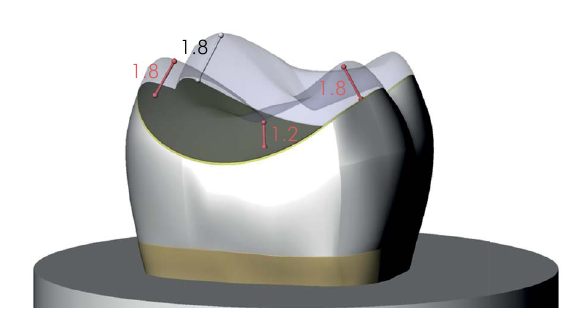
Figure 1. Three-dimensional model of a restored molar with occlusal veneer of 1.2-mm minimum